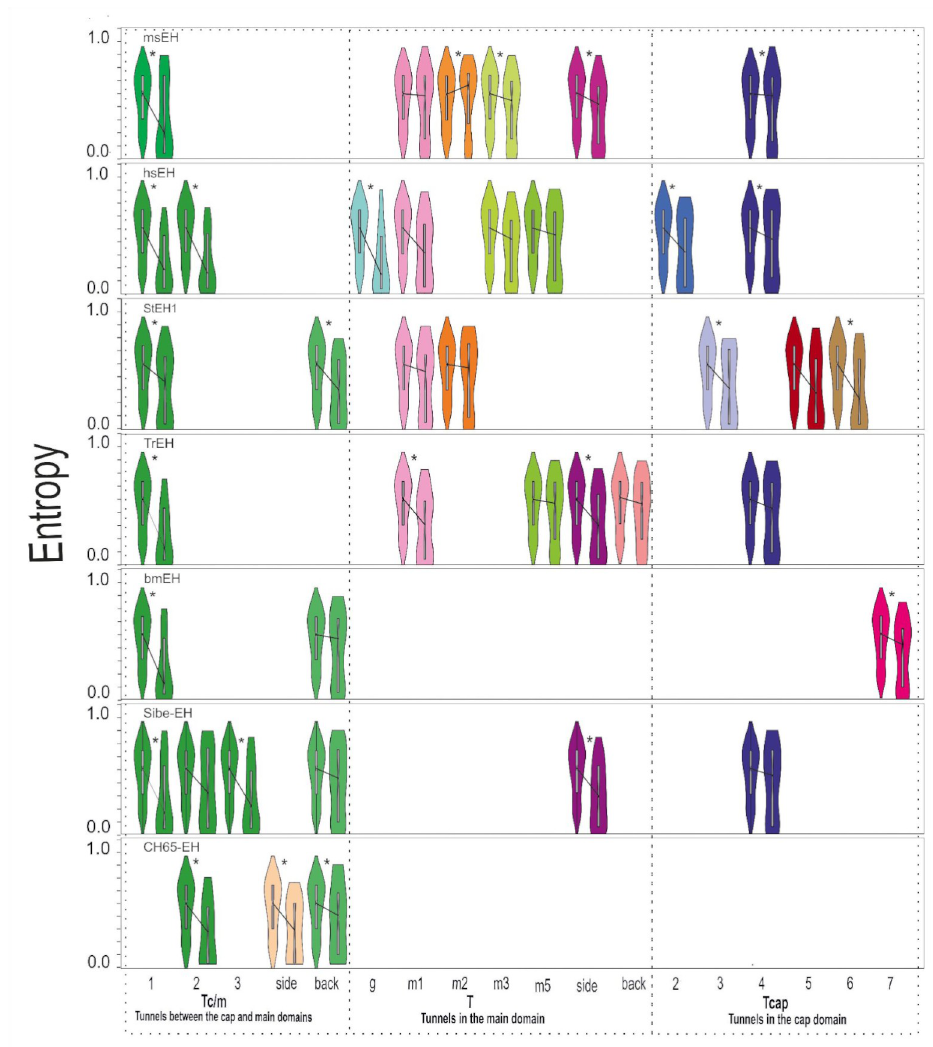
Fig 4. Distribution of the entropy values and median entropy values of tunnel-lining residues without the surface residues, and the remaining positions of the trimmed MSA (violin plots), for all analysed soluble epoxide hydrolase structures. Figure represents the data shown in S12 Table . Statistically significant pairwise differences in median distances are marked by a star ( � ).